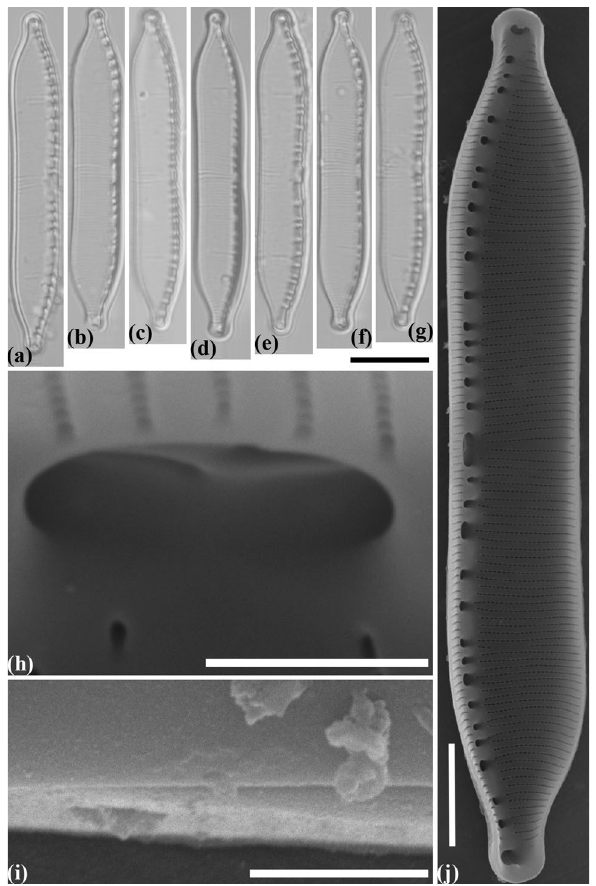
Figure 7. Valve morphology of the strain Hantzschia stepposa MZ–BH12. ( a – g ) Light micrographs. ( h ) Scanning electron micrograph, interior of valve at valve center, showing bent to opposite directions of the central raphe endings. ( i ) Scanning electron micrograph, exterior of valve at valve center, showing almost straight the central raphe endings. ( j ) Scanning electron micrograph, interior of valve. Scale bars ( a – g ) = 10 µm, ( h , i ) = 1 µm, ( j ) = 5